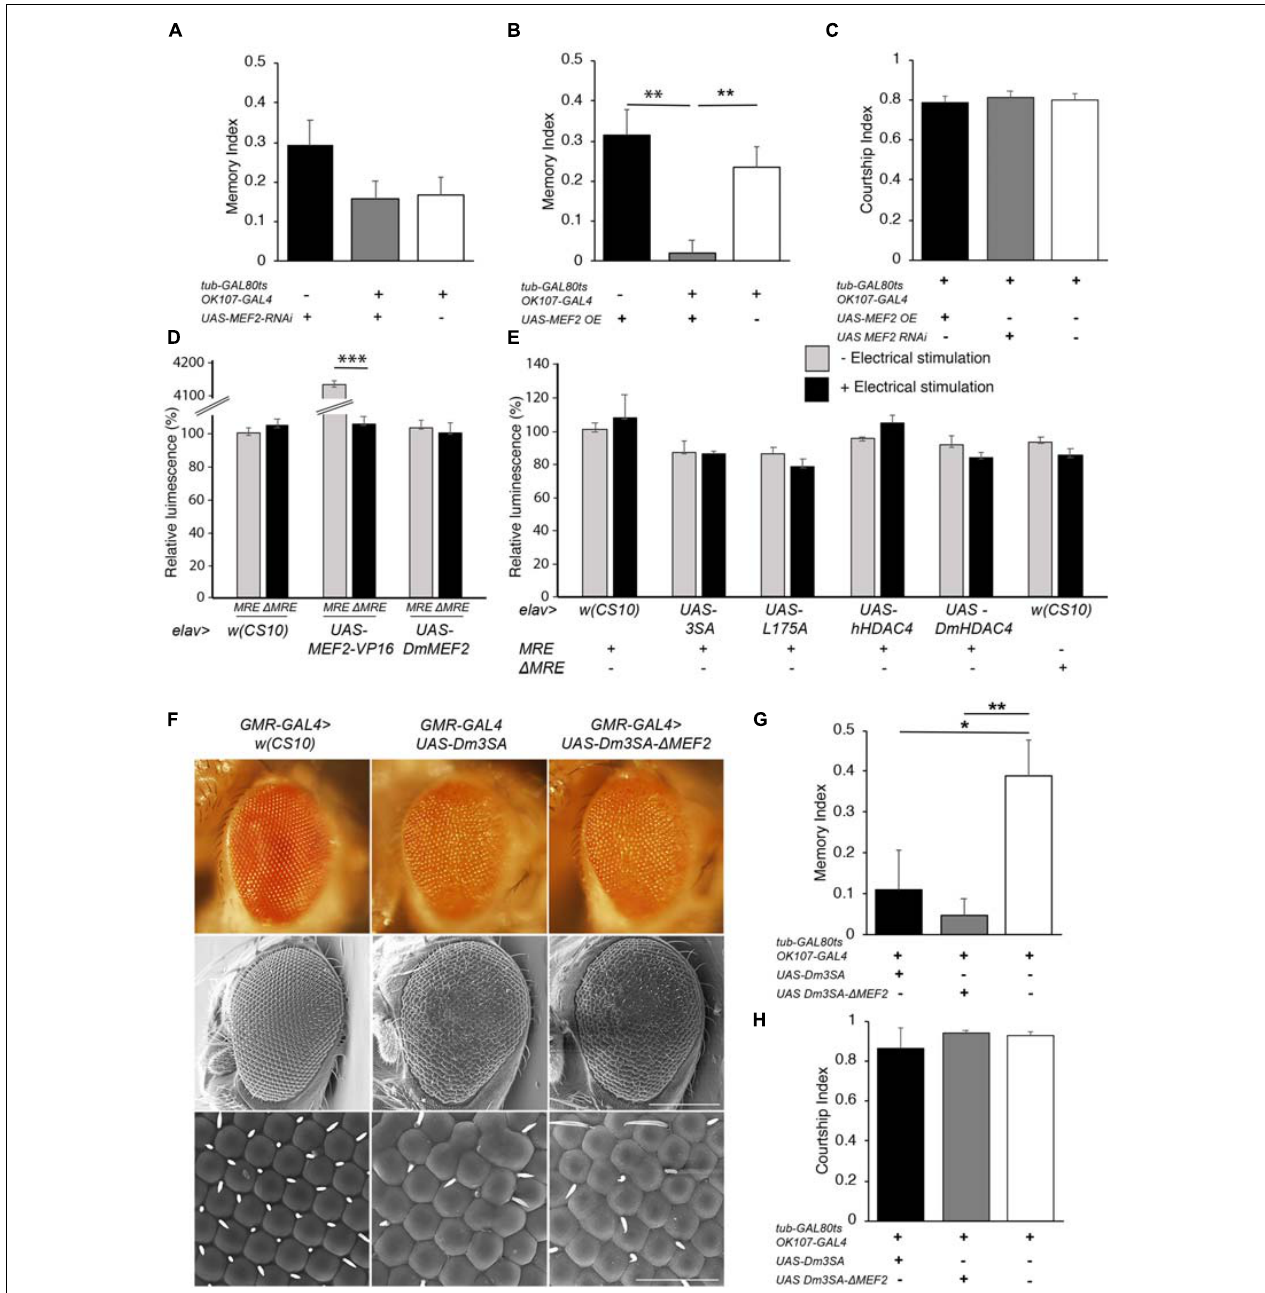
FIGURE 6 | Functional analysis of the MEF2/HDAC4 interaction. (A–C,G,H) All genotypes were generated by crossing OK107-GAL4; tub-GAL80 ts females to males of the indicated genotype. Expression was induced in the adult brain of progeny by raising the flies at 18 ◦ C until after eclosion, then placing at 30 ◦ C for 72 h. The courtship suppression assay was carried out as per Figure 4B . (A) MEF2 knockdown in Kenyon cells does not alter LTM [ANOVA, F ( 2 , 158 ) = 2.06, p = 0.13]. (B) Overexpression of MEF2 in Kenyon cells impairs LTM [ANOVA, F ( 2 , 156 ) = 10.91, p < 0.0001; post-hoc Tukey’s HSD, * p < 0.01]. (C) Courtship activity was not altered by knockdown or overexpression of MEF2 [ANOVA, F ( 2 , 174 ) = 1.62, p = 0.201]. (D) elav-GAL4 driven expression of MEF2-VP16 activated expression of luciferase in MRE-luc but not (cid:49) MRE-luc brains [ANOVA, F ( 5 , 18 ) = 1645, p < 0.000001; post-hoc Tukey’s HSD, * p < 0.000001]. Expression of DmMEF2 did not increase luciferase activity above background levels in MRE-luc brains. (E) Electrical stimulation did not increase luciferase above background levels [ w(CS10 ) control ± electrical stimulation, t -test t ( 5 ) = 0.691, p = 0.520] and there was no alteration in luciferase activity on expression of wild-type or mutant HDAC4 [ANOVA F ( 5 , 17 ) = 1.46, p = 0.253]. (F) Stereomicrographs and scanning electron micrographs of Drosophila eyes in which the indicated transgenes are expressed with the GMR-GAL4 driver. Top panel: Stereomicrographs. Middle panel: SEM 250 × magnification. Scale bar = 200 µ m. Lower Panel: SEM, 1,500 × magnification. Scale bar = 40 µ m. (G) Mutation of the MEF2 binding site did not prevent 3SA-induced impairment of LTM as compared to the control group [ANOVA, F ( 2 , 29 ) = 5.53, p = 0.009; post-hoc Tukey’s HSD, * p < 0.05, ** p < 0.01]. H. Courtship activity was unaffected by expression of Dm3SA or Dm3SA (cid:49) MEF2 [ANOVA, F ( 2 , 29 ) = 0.85, p =